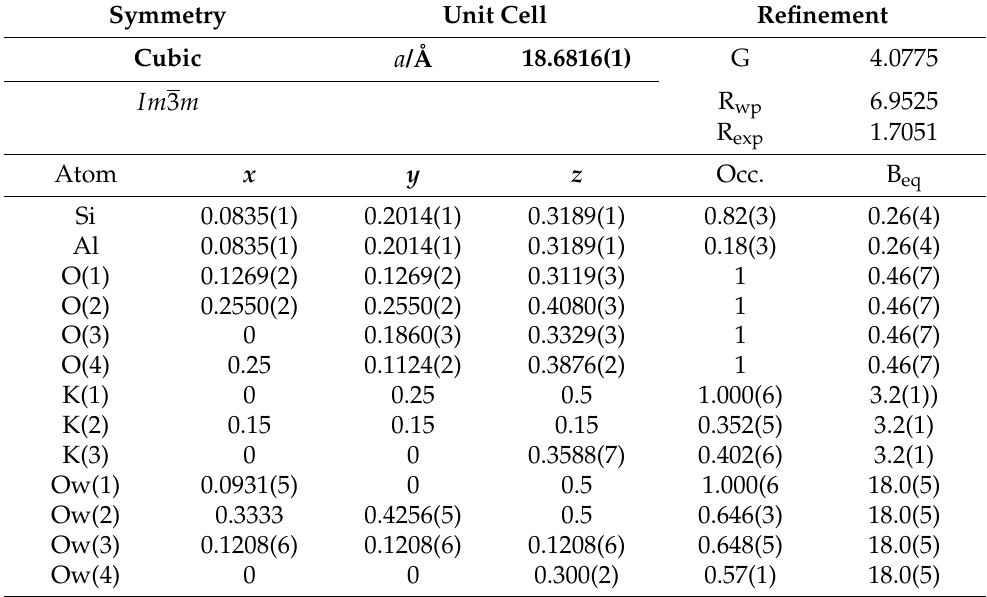
Table 5. Final refined unit cell parameters and crystallographic sites for the empty zeolite ZK-5 sample. ‘Occ.’ refers to the fractional occupancy of the relevant crystallographic site. Error in